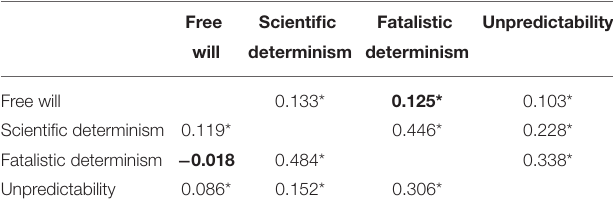
TABLE 6 | Inter-subscale correlation coefficients of the FAD-J and the FAD +